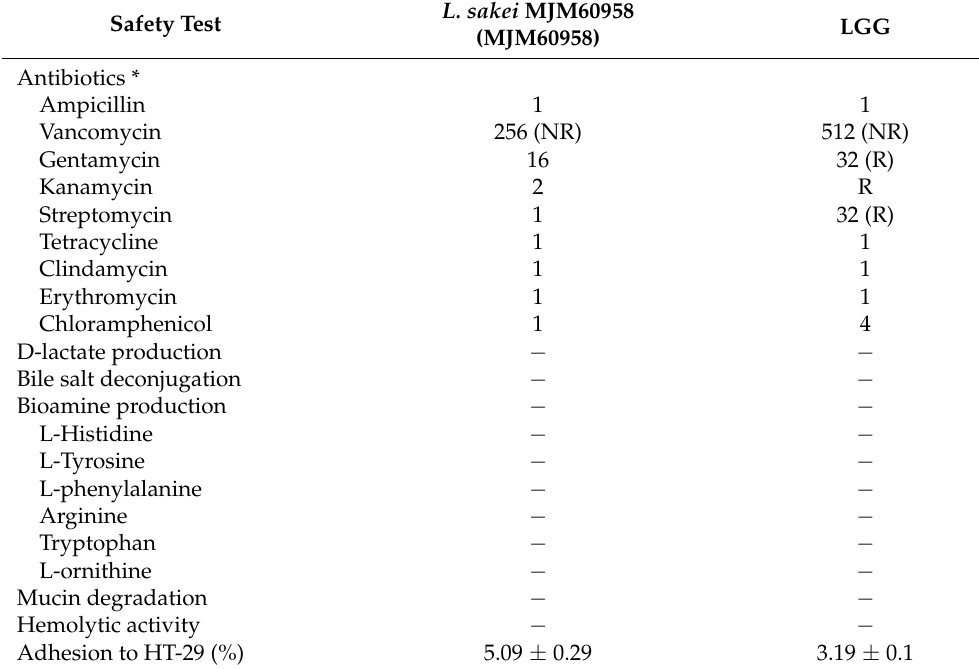
Table 2. Safety assessment of L. sakei